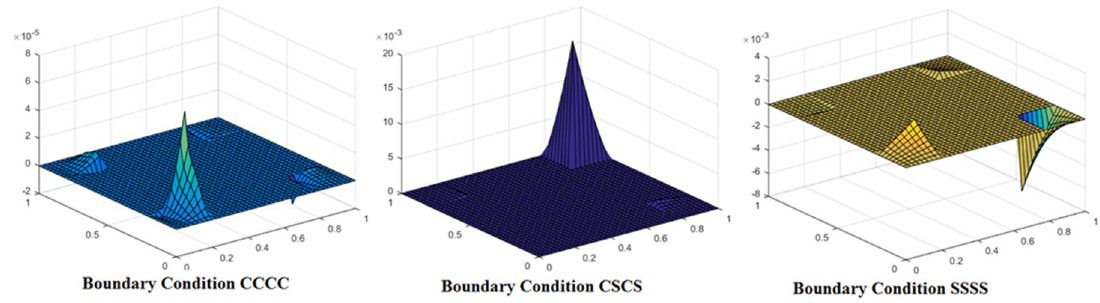
Figure 9. Mode shape for laminated composite plate with lamination scheme C, a / h = 5, cutout size 0.6a and N x / N y = 1, N xy = 1.